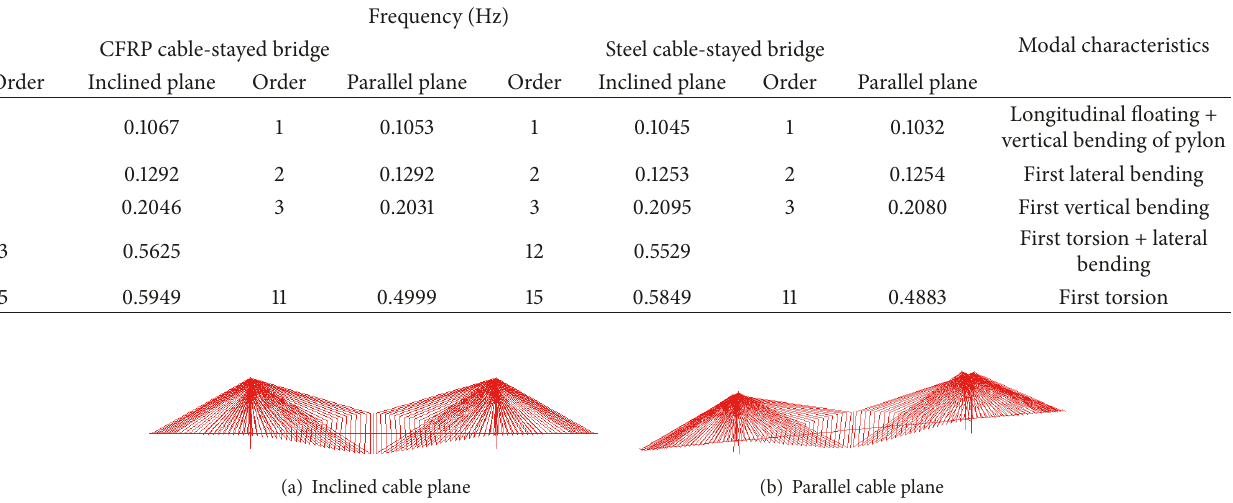
Table 8: Dynamic characteristics of the two cable-stayed bridges with different types of cable plane.